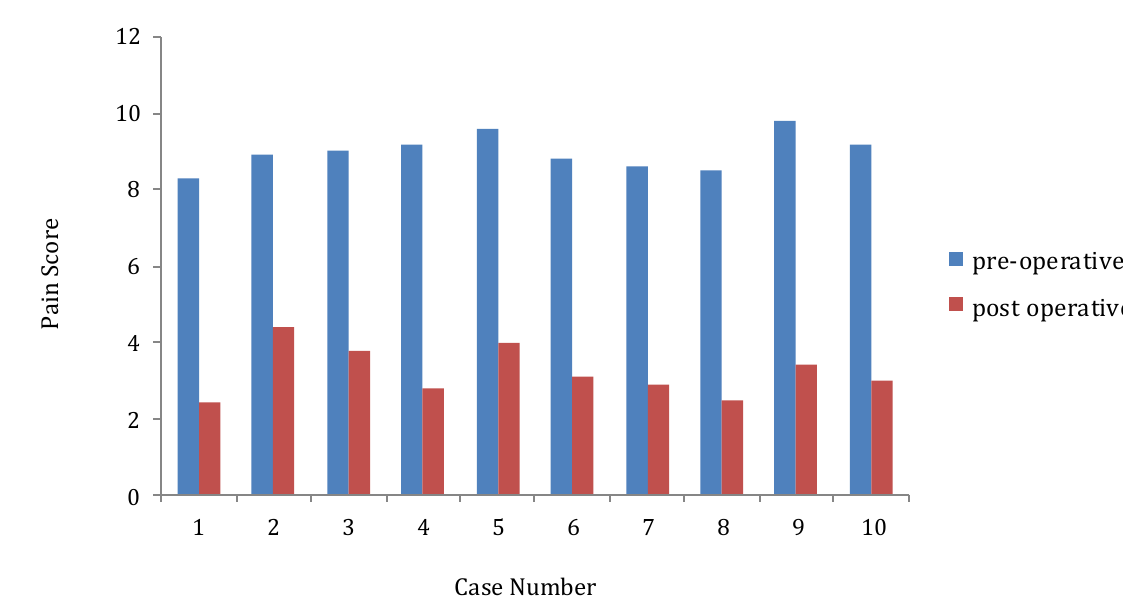
Figure 1. Pre- and post-operative pain scores (pre-operative 8.99+1.1, post-operative